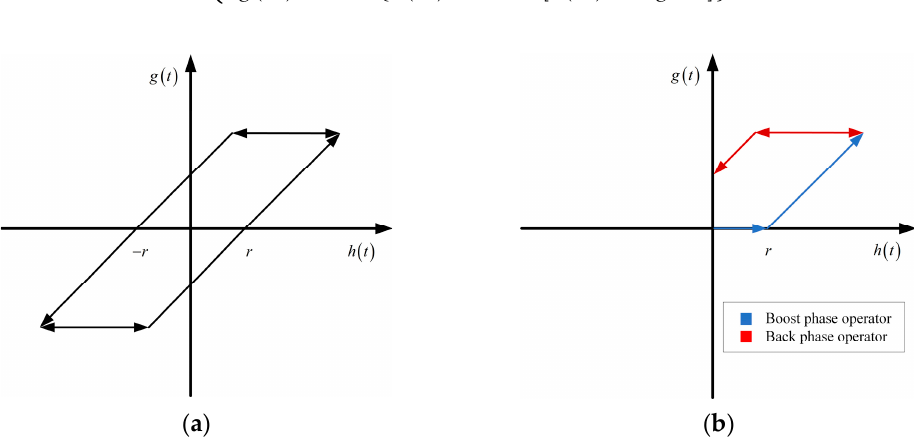
Figure 8. Play operator: ( a ) the complete operator model; ( b ) the one-sided operator model. In Equation (6), r is the threshold value of the play operator, n ∈ [ 1, e ] , 0 = t 0 < t 1 < t 2 < · · · < t s is the division on the input signal interval. When using the CPI model to study the piezoelectric effect hysteresis problem, the initial form variable of the displacement is usually noted as 0, so g 0 = 0 is